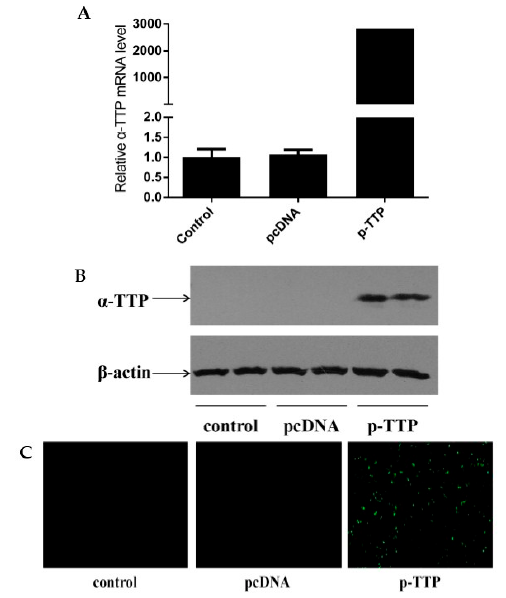
Figure 1. Expression of human α -tocopherol transfer protein ( α -TTP) eukaryotic expression vector in Human Hepatoma cells (HepG2). ( A ) Result of quantitative real-time PCR; ( B ) Result of Western blot; ( C ) Result of Immunofluorescence (10×). pcDNA: pcDNA3.1-mycHisa empty vector; p-TTP: human α -TTP eukaryotic expression vector.